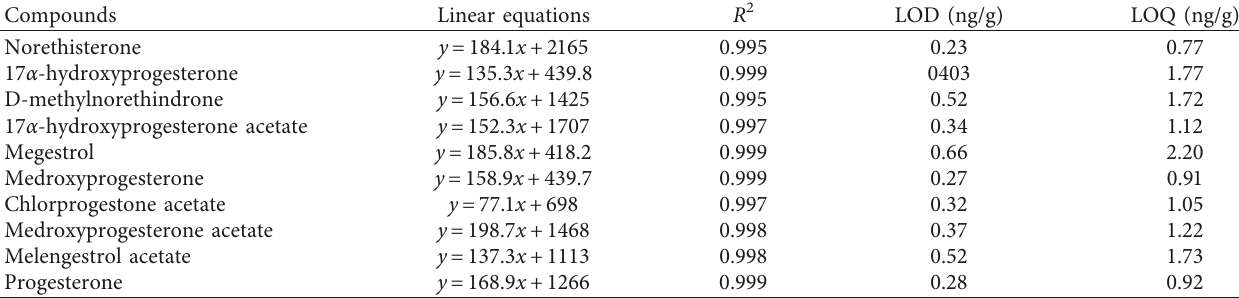
Table 2: Regression equations, correlation coefficients ( R 2 ), LOD, and LOQ of 10 progestins. Compounds